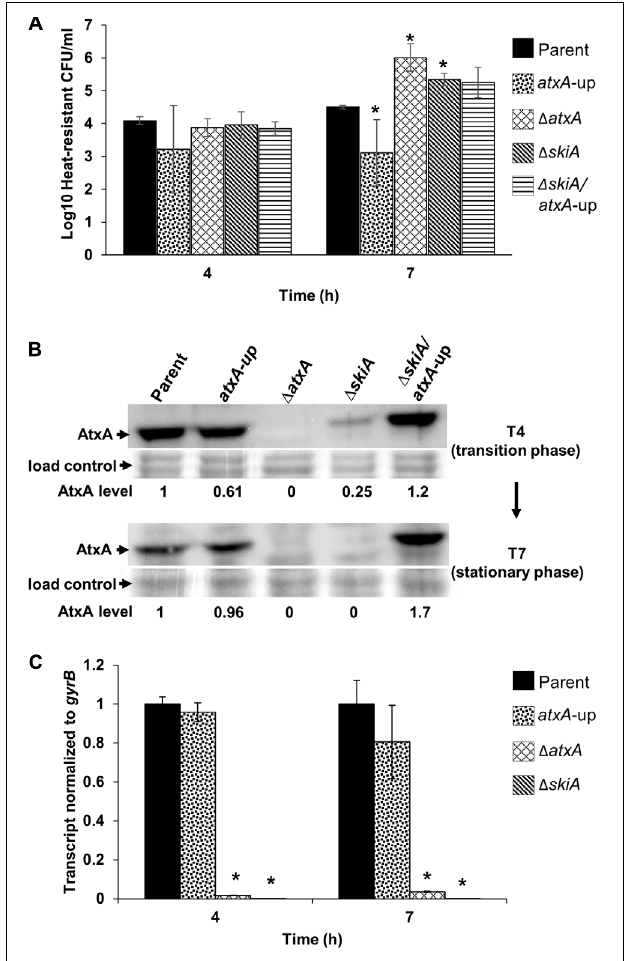
FIGURE 4 | Spore quantitation, AtxA protein abundance, and skiA transcript levels in CACO 3 + 5% CO 2 . (A) Heat-resistant CFU/ml of parent and mutant derivatives. (B) AtxA protein levels in parent and mutant strain backgrounds. Culture samples were obtained during transition (T4) and stationary (T7) phases of growth, and subjected to Western blot analysis using rabbit α -AtxA antibody. Protein loads were determined based on OD 600 values and normalized to Ponceau S stained membranes. These data are representative of three separate experiments. (C) RT-qPCR of skiA transcripts at 4 and 7 h, respectively, normalized to the parent control. These data represent average values of detectable transcripts from three independent cultures. Asterisks denote p -values ≤ 0.05 relative to parent.